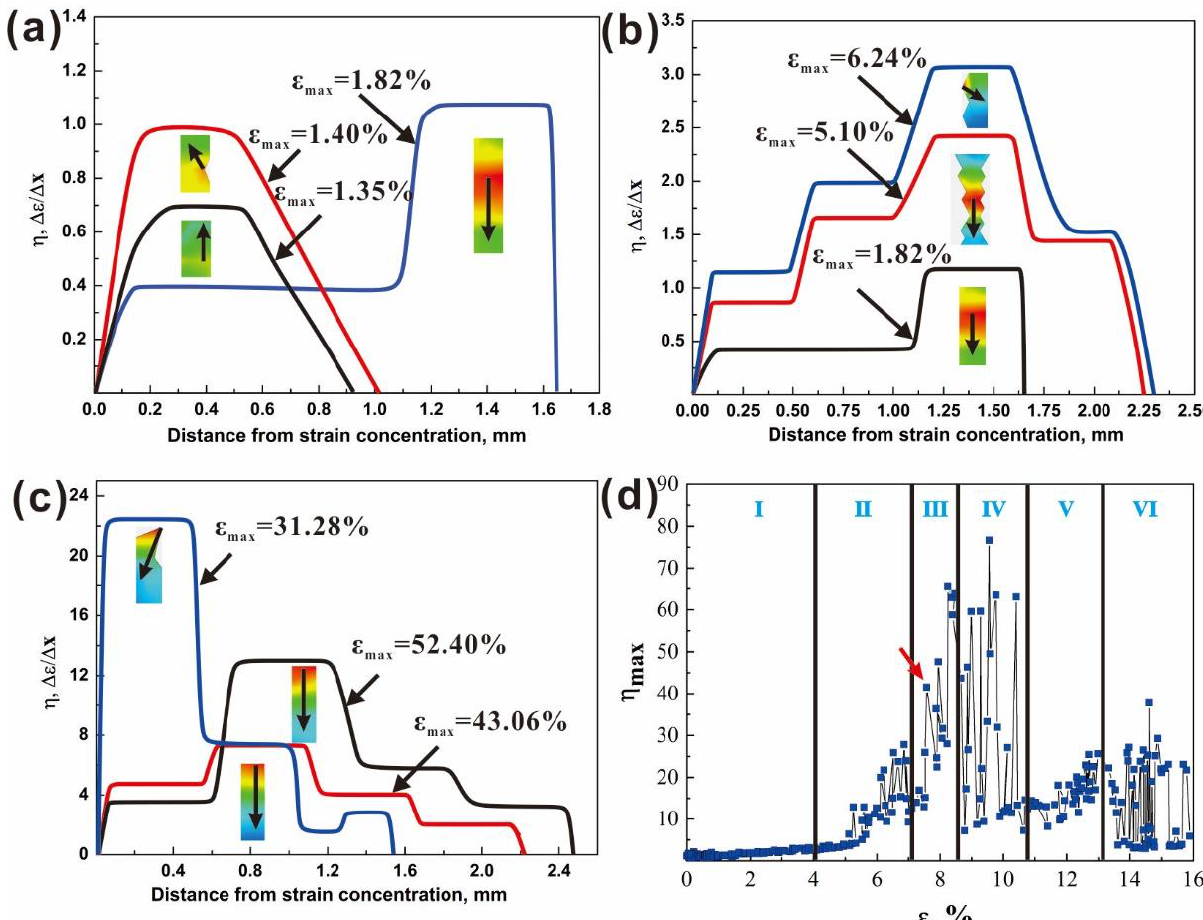
Figure 7. Relationship between the strain gradient and the distance from the strain concentration at different applied strains in the ( a ) elastic, ( b ) work hardening, and ( c ) instability stages, respectively. ( d ) The maximum strain gradient – strain curve.